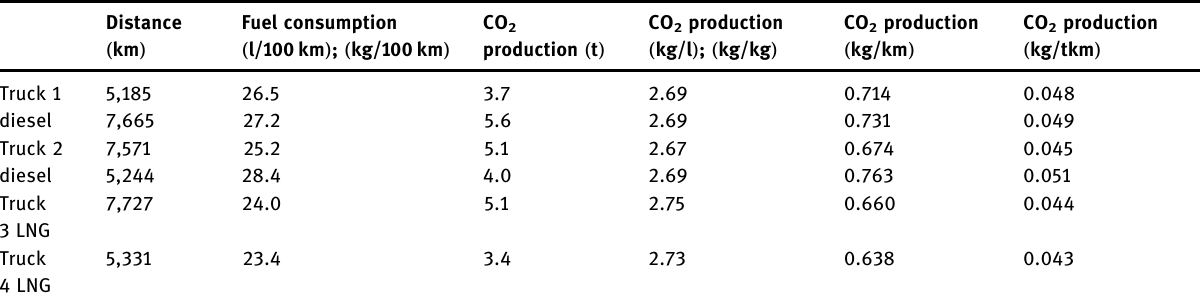
Table 3: CO 2 production from trucks with trailers on regular freight lines Distance ( km )